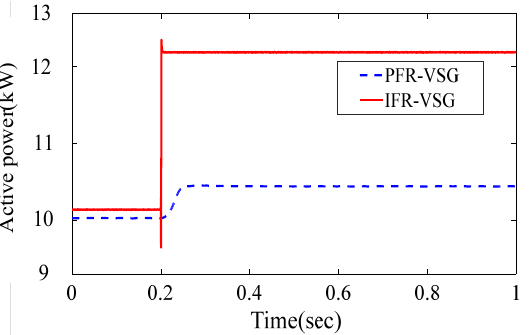
Figure 8. Active power regulation ability between the power-frequency control (PFC)-VSG and the autonomous frequency control (AFC)-VSG under the sudden load increase condition.